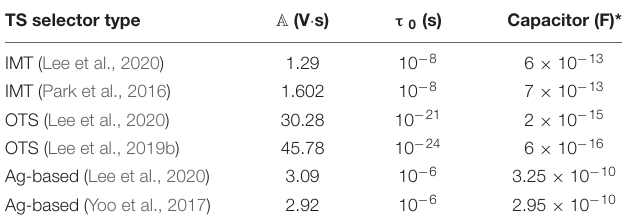
TABLE 1 | Key parameters extracted from the reported threshold switching (TS)